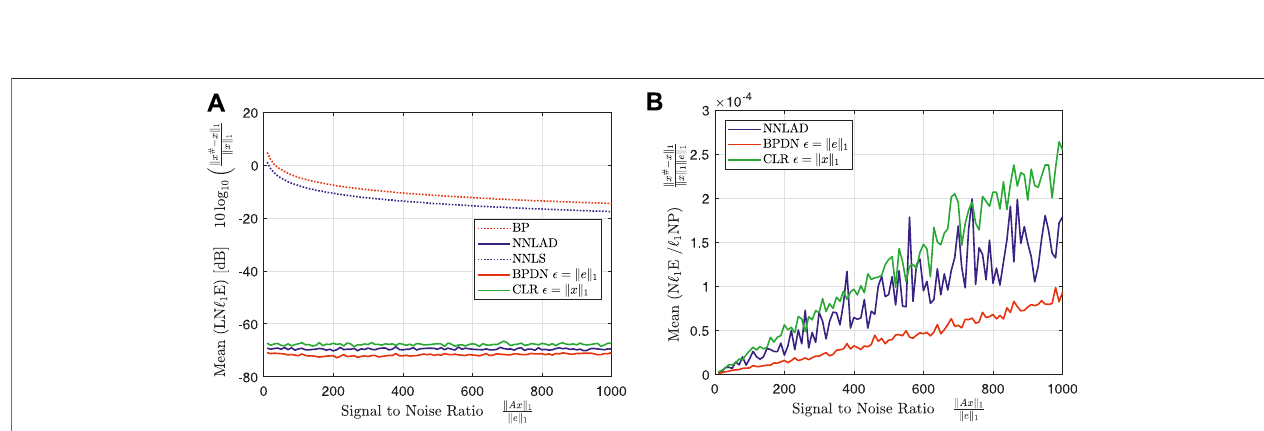
FIGURE 3 | Performance of NNLAD for noise with even mass and varying noise power. (A) The NNLAD and NNLS recover reliably for all signal to noise ratios. (B) The estimation error scales linearly with the noise power.